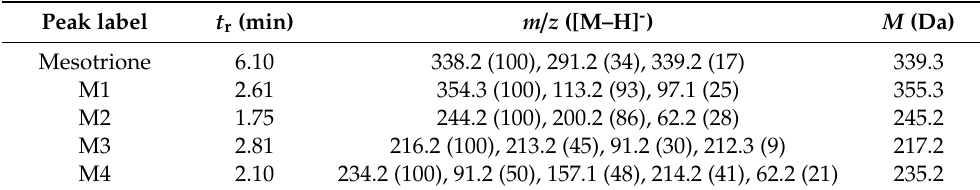
Table 1. Retention time of chromatography peak, detected m / z values (the first is the precursor ion, the fragments are listed below with relative abundance), and the calculated molecular mass of the mesotrione and the detected intermediates. ( m / z value is related to the deprotonated form ([M–H] - , while M is the average mass of molecule calculated by the ChemSketch